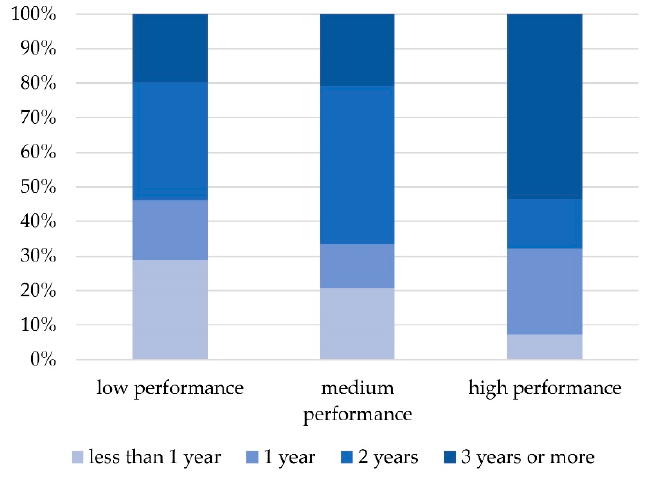
Figure 3. Timespan of activity by performance category.